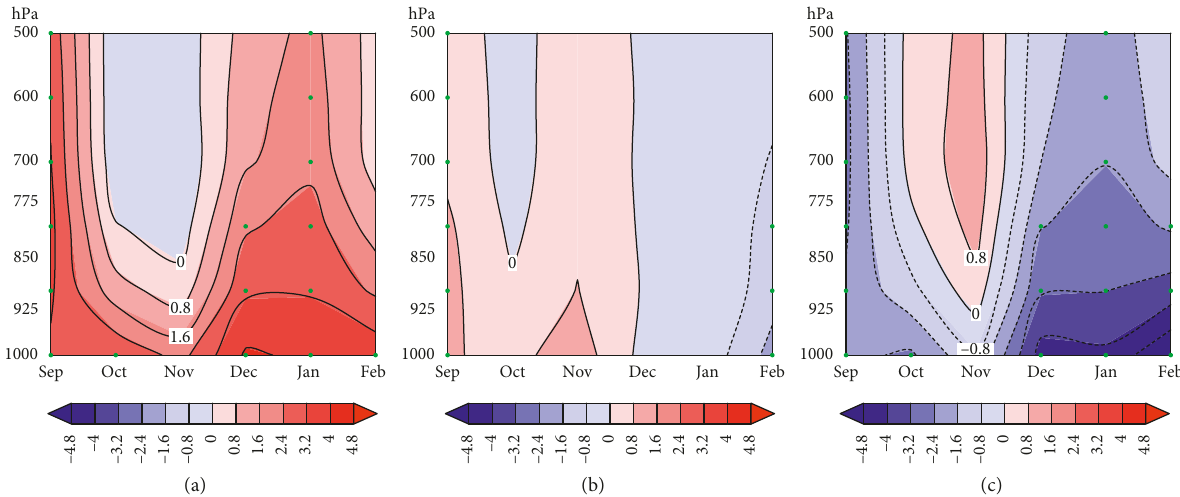
Figure 6: Composite differences for (a) vertical profiles of the temperature (shaded; unit: ° C) in the BK region/NR (30 ° E–100 ° E, 75 ° N–85 ° N) from September to the following February between selected low DBKI years and high DBKI years in September. (b, c) The same as (a) but for the midlatitude region/SR (30 ° E–100 ° E, 40 ° N–50 ° N) and the differences between the SR and the NR, respectively. The green dot denotes the values that are statistically significant with significance exceeding 0.1 based on the results of t -tests.